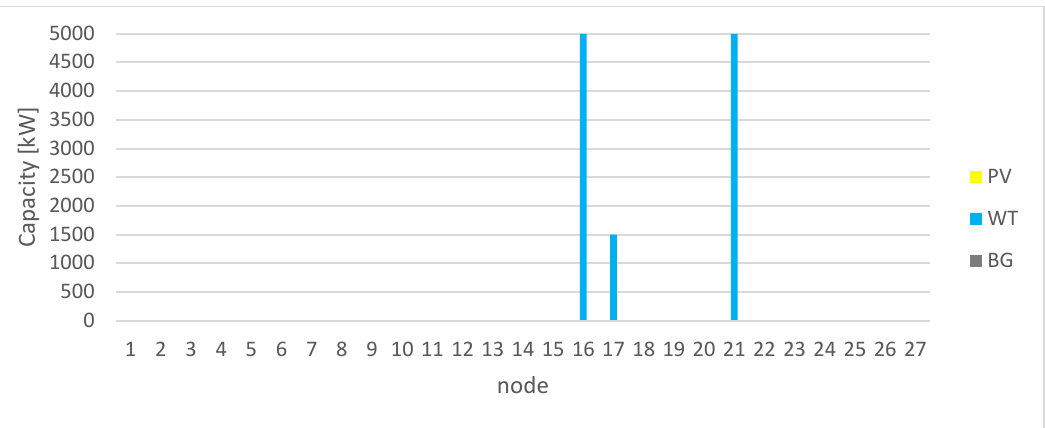
Figure A5. Capacity structure for scenario “3”.